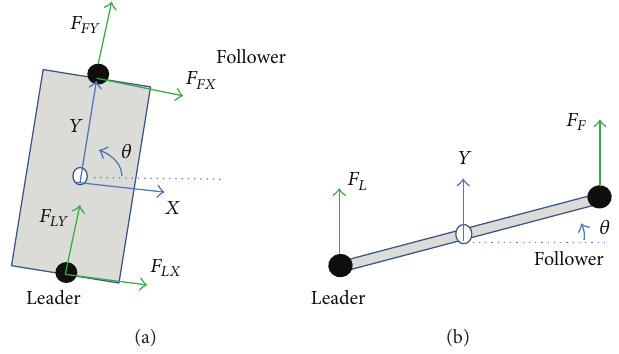
Figure 10: Table positioning (left). Board positioning